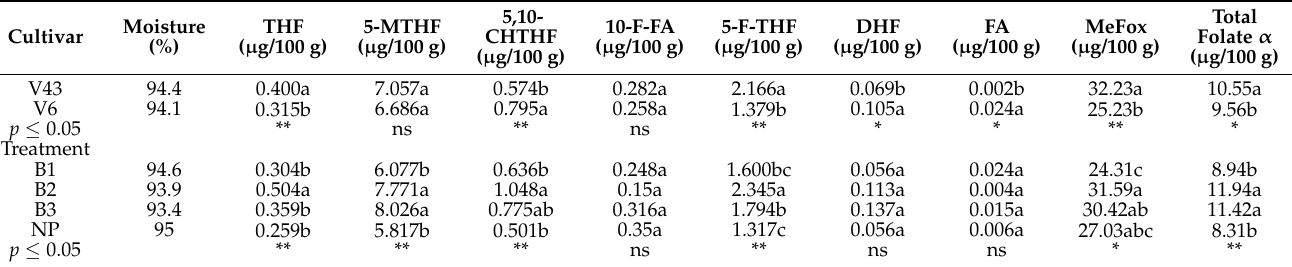
Table 5. Folate derivatives of cayenne pepper fruits as influenced by PGPR and chili residue synergy.